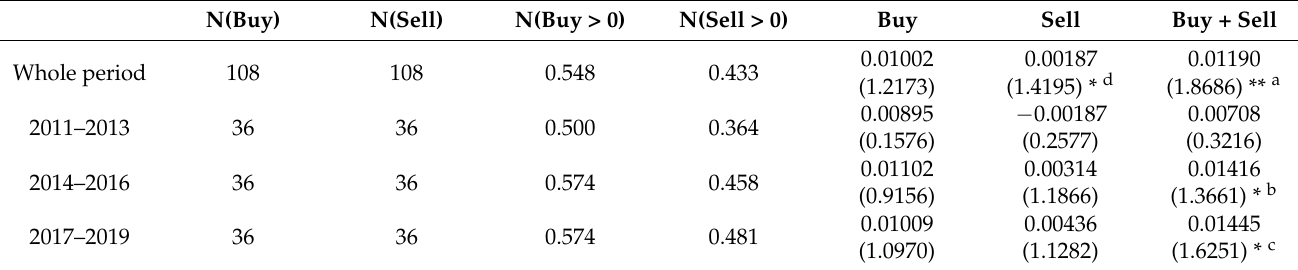
Table 9. t -test Output for the MACD (4,22,3) Model with the ‘30%10d’ Strategy vs. the MACD (12,26,9) Model.